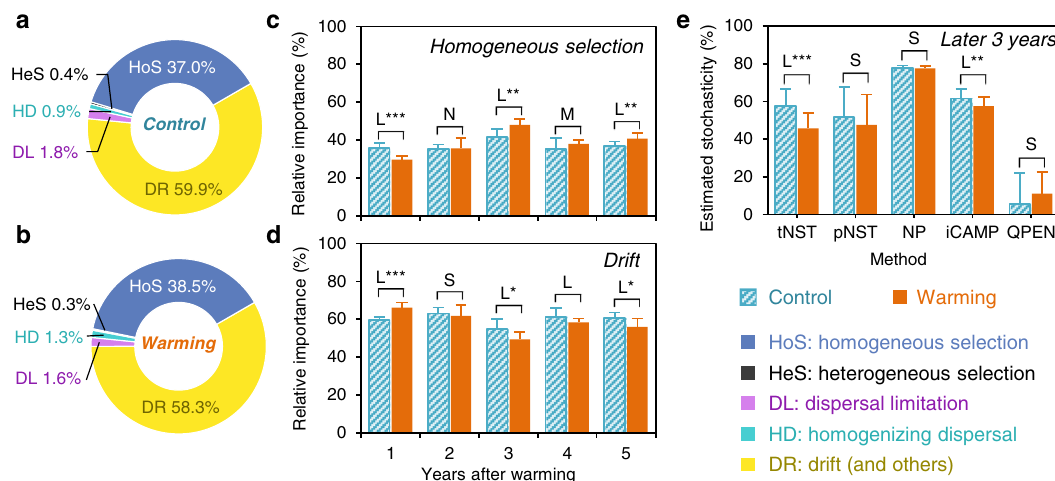
Fig. 3 Relative importance of different ecological processes in response to warming. a Under control. b Under warming. c Changes of homogeneous selection under warming (orange bar) and control (aqua bar). d Changes of drift. a – d were estimated by iCAMP. e Stochasticity estimated by different methods in the later 3 years. One-side signi fi cance based on bootstrapping test was expressed as *** p < 0.01; ** p < 0.05; * p < 0.1. p = 0.001, 0.818, 0.014, 0.346, 0.035 in Year 1 – 5 for homogeneous selection; p = 0.001, 0.657, 0.066, 0.207, 0.058 in Year 1 – 5 for drift; p = 0.000, 0.542, 0.500, 0.014, 0.567 for tNST, pNST, NP, iCAMP, and QPEN, respectively. L, M, S, and N represented large (| d | > 0.8), medium (0.5 < | d | ≤ 0.8), small (0.2 < | d | ≤ 0.5), and negligible (| d | ≤ 0.2) effect sizes of warming, base d on Cohen ’ s d (the mean difference between warming and control divided by pooled standard deviation). Data are presented as mean values ± SD. Error bars represented standard deviations; c and d n = 6 comparisons among four biologically independent samples at each time point; e n = 18 comparisons = 6 comparisons in each of the 3 years. Source data are provided as a Source Data fi